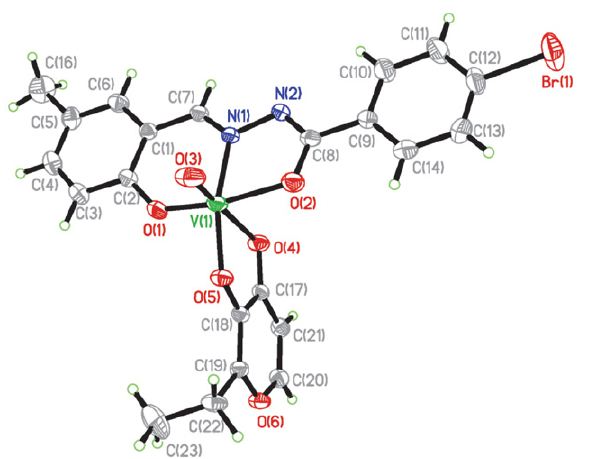
Fig. 1. An ORTEP diagram of complex 1 with atom labeling scheme and 30% probability thermal ellipsoids for all non-hydrogen atoms.